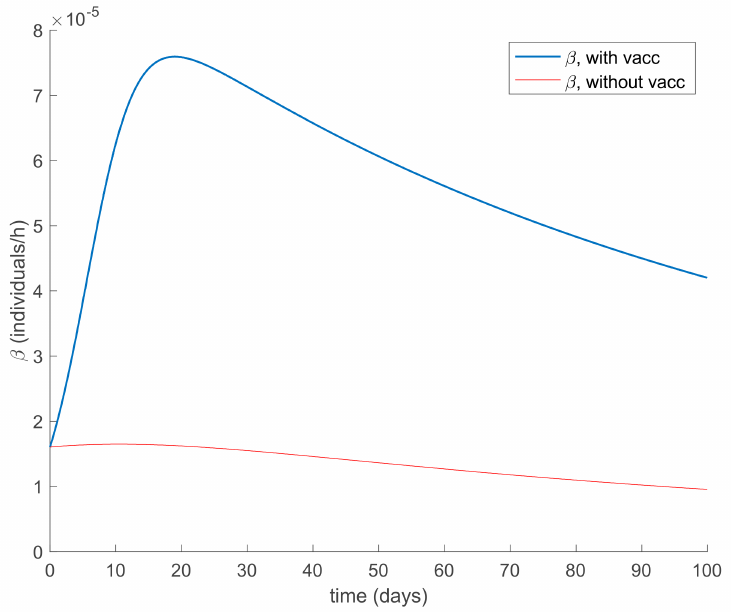
Figure 9. Different values of β calculated through (30) corresponding to the application of constant vaccination and the absence of